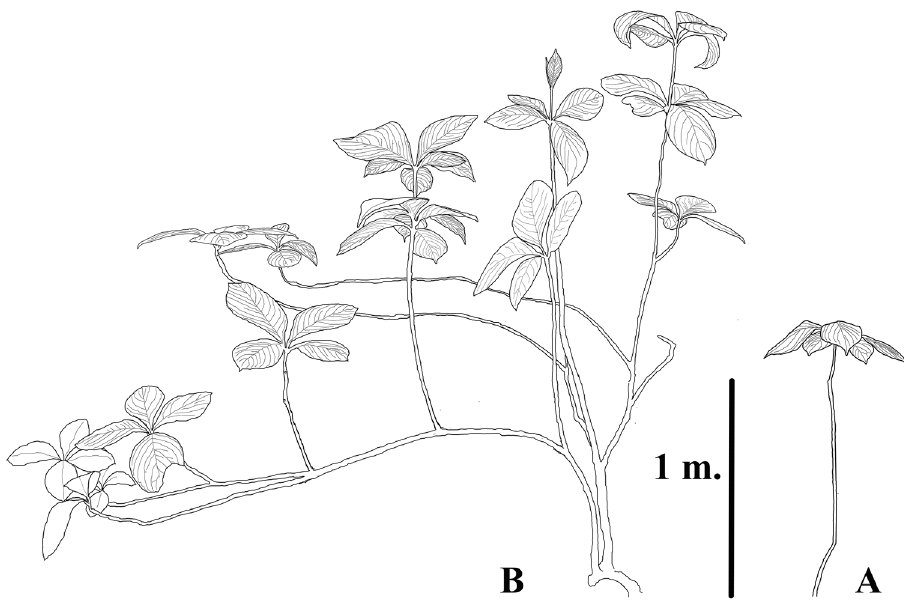
Figure 6. Two habit forms of Brunfelsia cabiesesiana found in the El Sira Mountains (drawing by